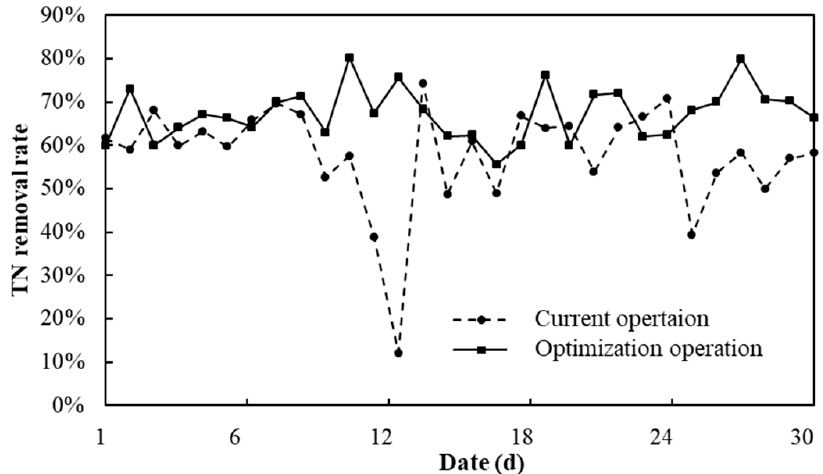
Figure 11. TN removal in the CAST process via optimization.